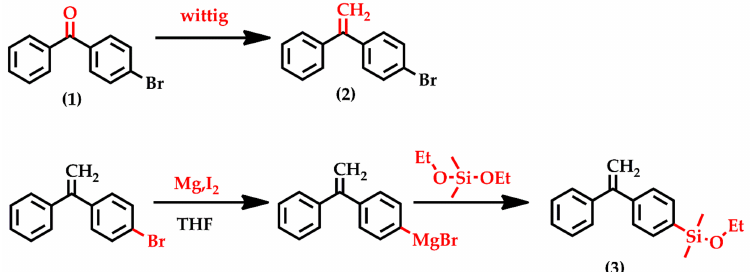
Figure 1. Synthetic route for 1-(ethoxydimethylsilyphenyl)-1-phenylethylene (DPE-SiOEt). ( 1 ) 4- bromobenzophenone; ( 2 ) 1-(4-bromophenyl)-1-phenylethylene (DPE-Br); ( 3 )